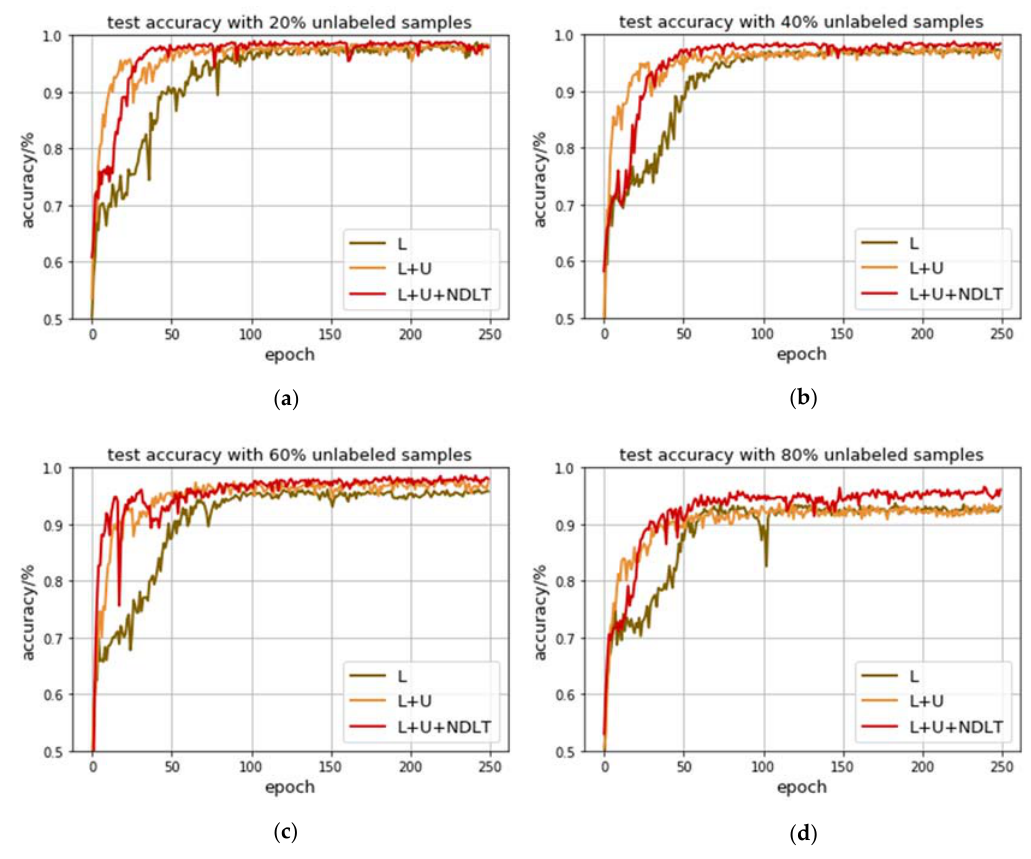
Figure 4. Recognition accuracy curves of L, L+U and L+U+NDLT: ( a – d ) correspond to 20%, 40%, 60%, and 80% unlabeled rate, respectively.